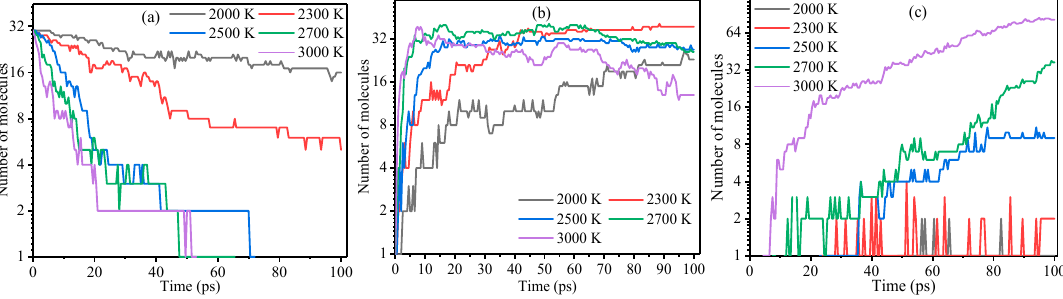
Figure 7. Pyrolysis composition of meta-aramid fiber at different temperatures: ( a ) C14, ( b ) C6–C13, and ( c ) C1–C5 products.